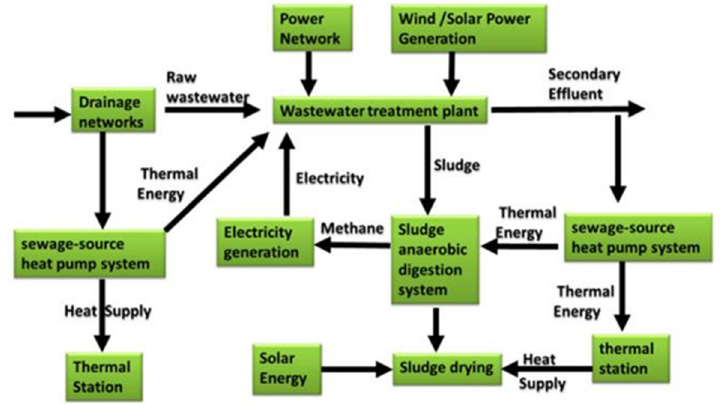
Figure 1. Energy utilization diagram of a wastewater treatment plant [12]. Reprint with permission [CC BY]; 2019, Licensee MDPI, Basel, Switzerland.